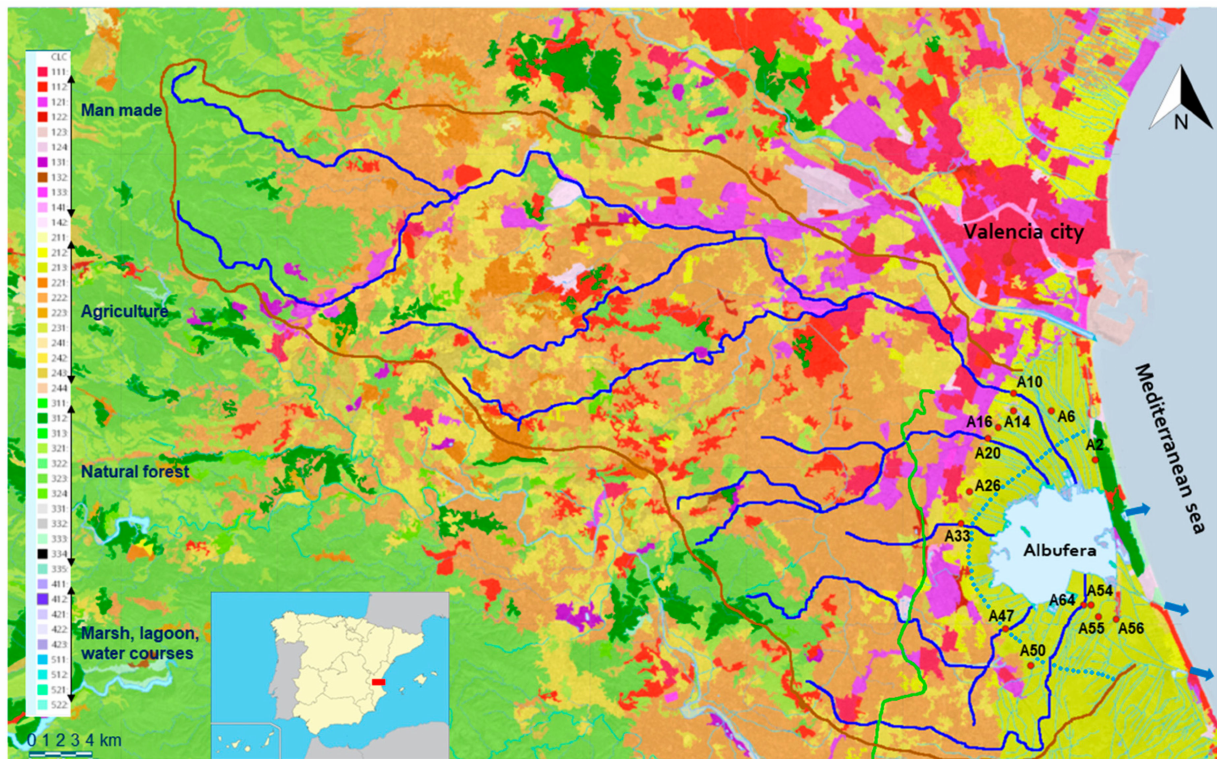
Figure 1. Situation of the Albufera of Valencia in the Iberian Peninsula. The blue lines indicate the natural courses affluent to the lagoon and main site sampling code used in the study. The light blue canals correspond to irrigation ditches in the rice fields. Green line indicates the course of Royal Canal of Jucar River (RCJ). The blue arrows indicate the location of the three communication canals between the lagoon and the Mediterranean Sea. The continuous brown line indicates the hydrologic basin. Dotted blue line indicates the polders area. Base image: CORINE Land Cover 2018 classification